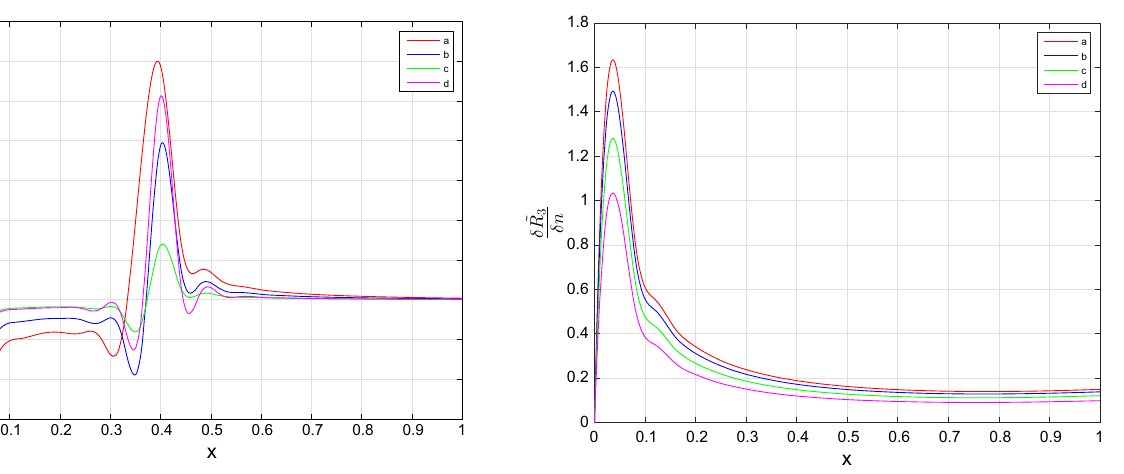
Fig. 5 Case 1: Perturbation through n , h , q . δ R 3 δ n = 1 , α = 0 . 2 , α 1 = 0 . 8 , h = 0 . 5, red curve q = 0 . 2 M (cid:7) , blue curve q = 0 . 4 M (cid:7) , green curve q = 0 . 6 M (cid:7) , magenta curve q = 0 . 64 M (cid:7)